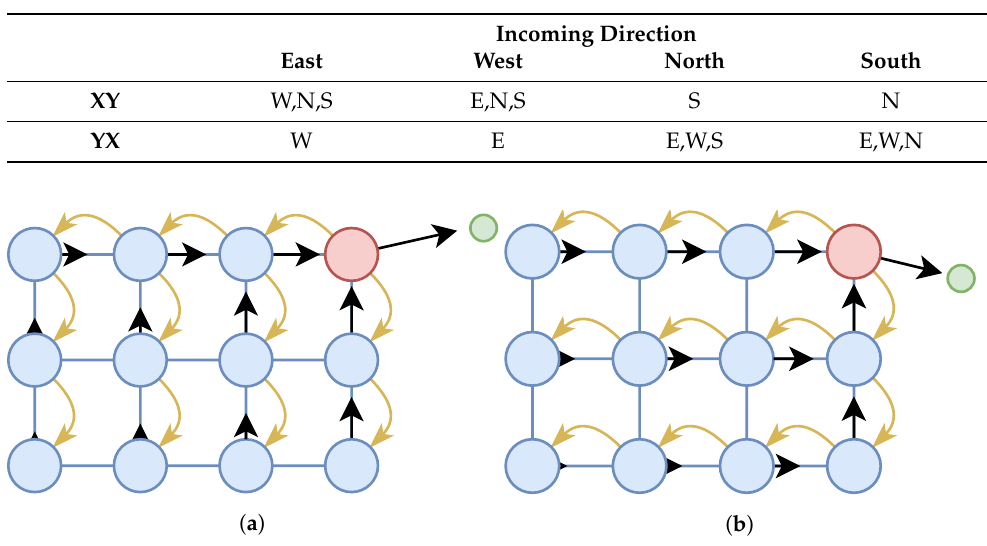
Table 1. Two dimensional update request propagation: output directions depend on the input direction and the current propagation mechanism.